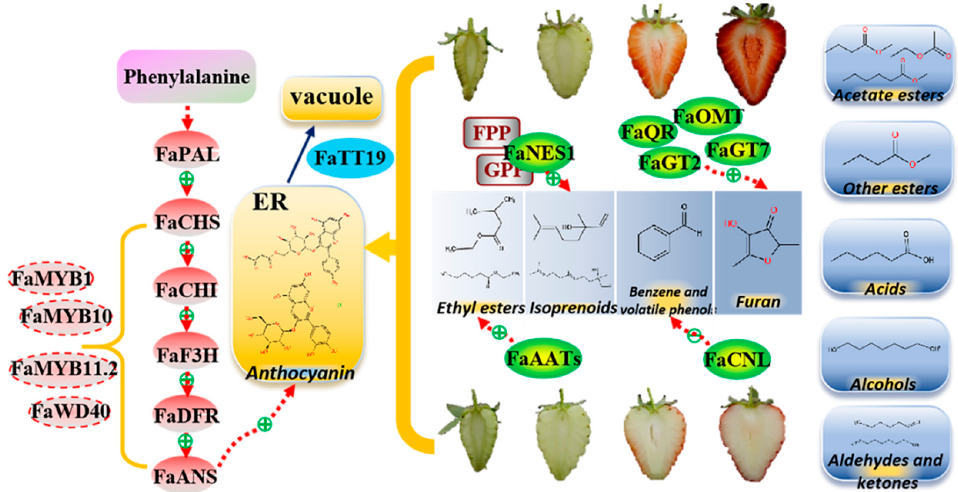
Figure 8. Proposed model for the differences in anthocyanins and volatile components in the fruit of ‘Sachinoka’ strawberry and its somaclonal mutant ‘Mixue’. ER: endoplasmic reticulum. Red ovals are structural genes of the anthocyanin biosynthetic pathway; red dashed ovals are key transcription factors regulating anthocyanins accumulation; blue oval is anthocyanins transport gene; green ovals are key genes in the volatile pathway; gray squares are substrates of the enzymes; blue squares are nine categories of volatile components in strawberry.